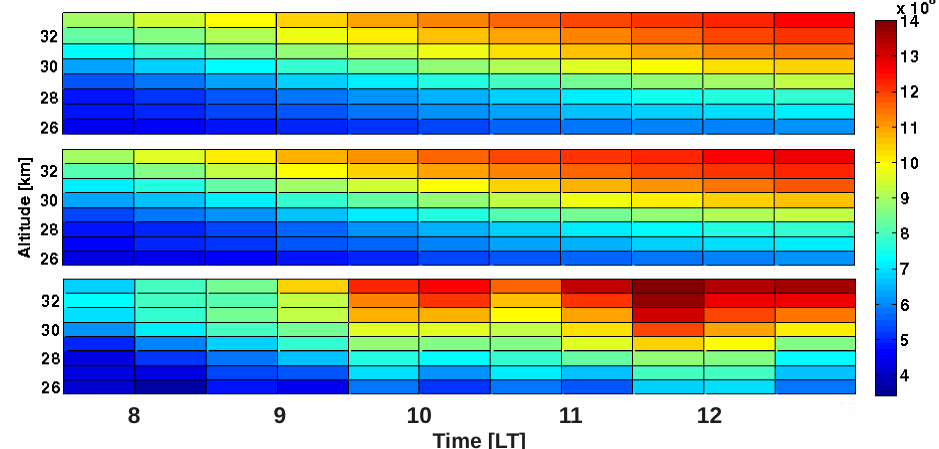
Figure 4. Temporal evolution of the NO 2 concentration in the tropical mid-stratosphere (5.1 ◦ S, 43.6 ◦ W) for 13 June 2005, using the JPL- (λ,T ) i.e. s 1 = 1.0 and s 2 = 1.0 (upper panel). Middle panel: same as in the upper panel, but with the 2011 recommendation for σ N 2 O 5 inferred s 1 = 1.6 and s 2 = 0.9. Lower panel: measured NO 2 . Units are given in moleccm − 3